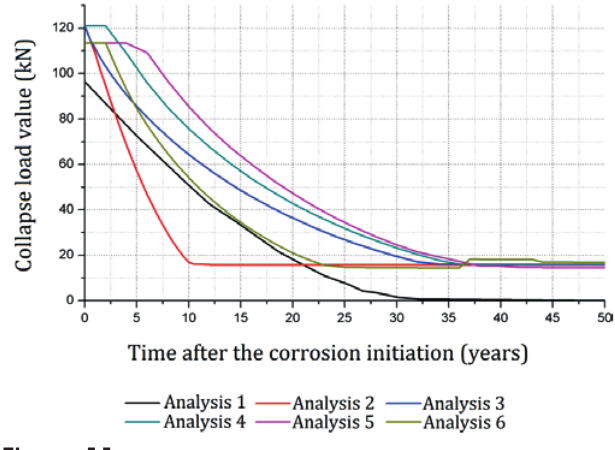
Figure 11 Collapse load value reduction along time. Time considered after the time for corrosion